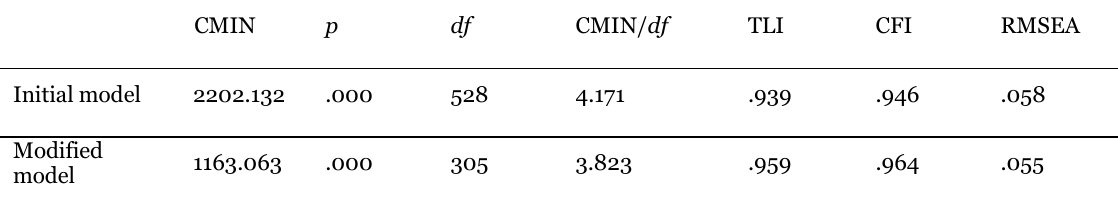
Correlation Matrices and Discriminant Validity